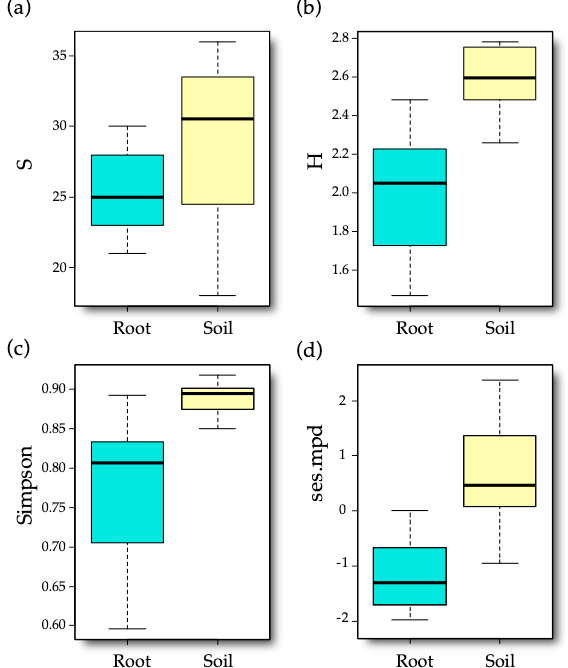
Table 1. Linear models showing the effect of sample type (soil vs. root), cultivar, and their interaction on diversity indices of the arbuscular mycorrhizal (AM) fungal communities. F values and degrees of freedom (as subscripts) are shown. Bold letters indicate significant variables: * p < 0.05; ** p < 0.01; *** p < 0.001.